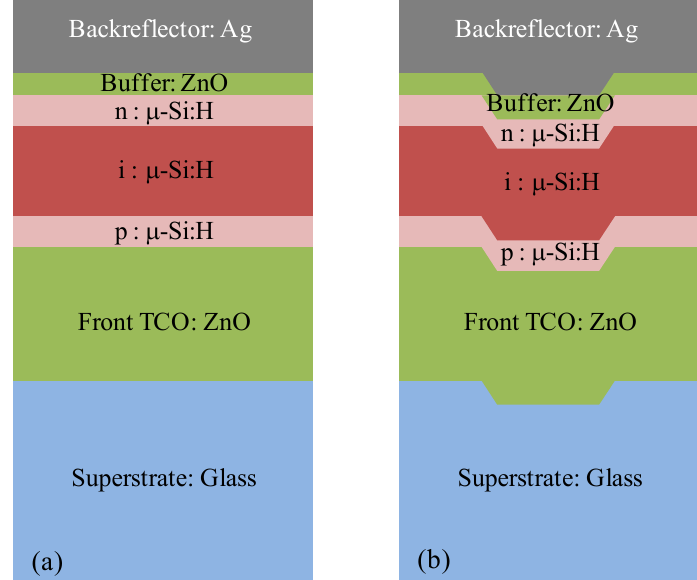
Figure 1. Schematic of the layers that constitute the fabricated solar cells for flat ( a ) and textured ( b )